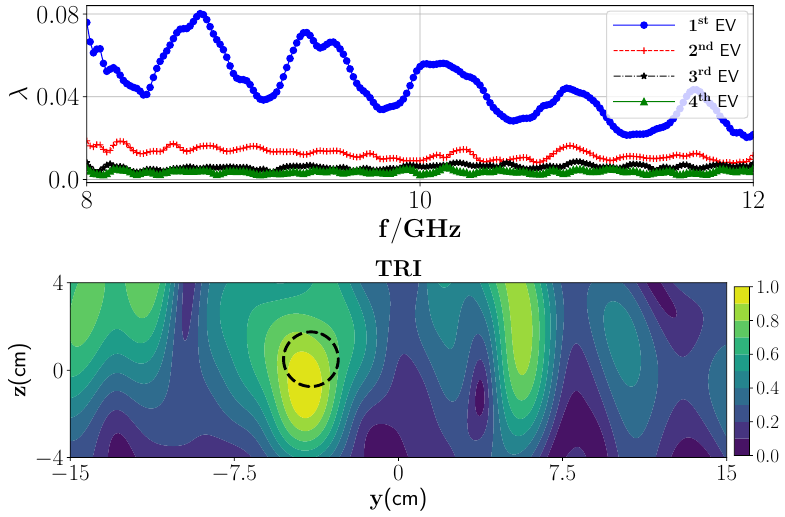
Figure 14. ( Top ) Magnitude of the first four eigenvalues versus the frequencies and ( bottom ) TRI- DORT reconstruction image of one wet spot when the second layer is PEC